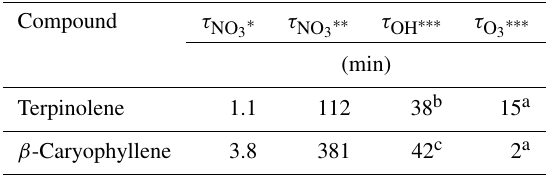
Table 6. Atmospheric lifetimes of terpinolene and β -caryophyllene with respect to their oxidation by NO 3 and OH radicals and by